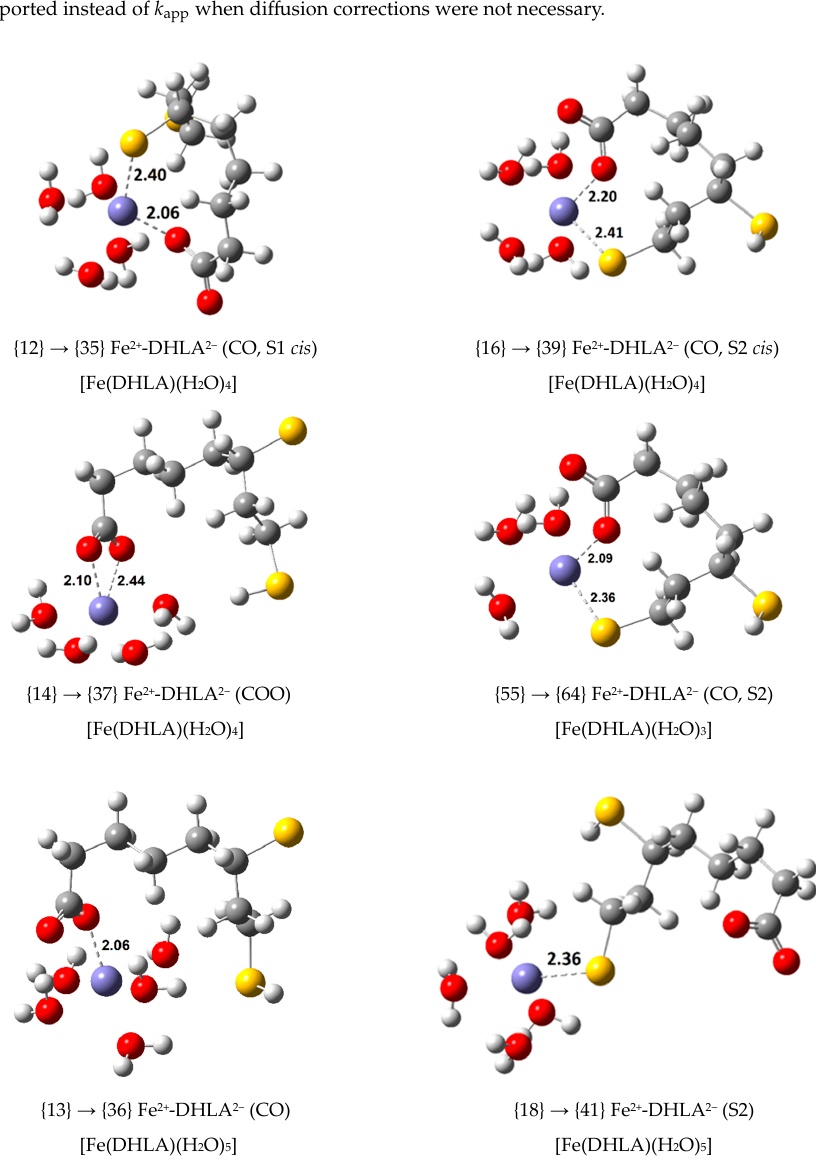
Figure 9. Optimized geometry (bond distances in Å) of the Fe(II) complexes that participate in the redox reactions reported in Table 5. redox reactions reported in Table